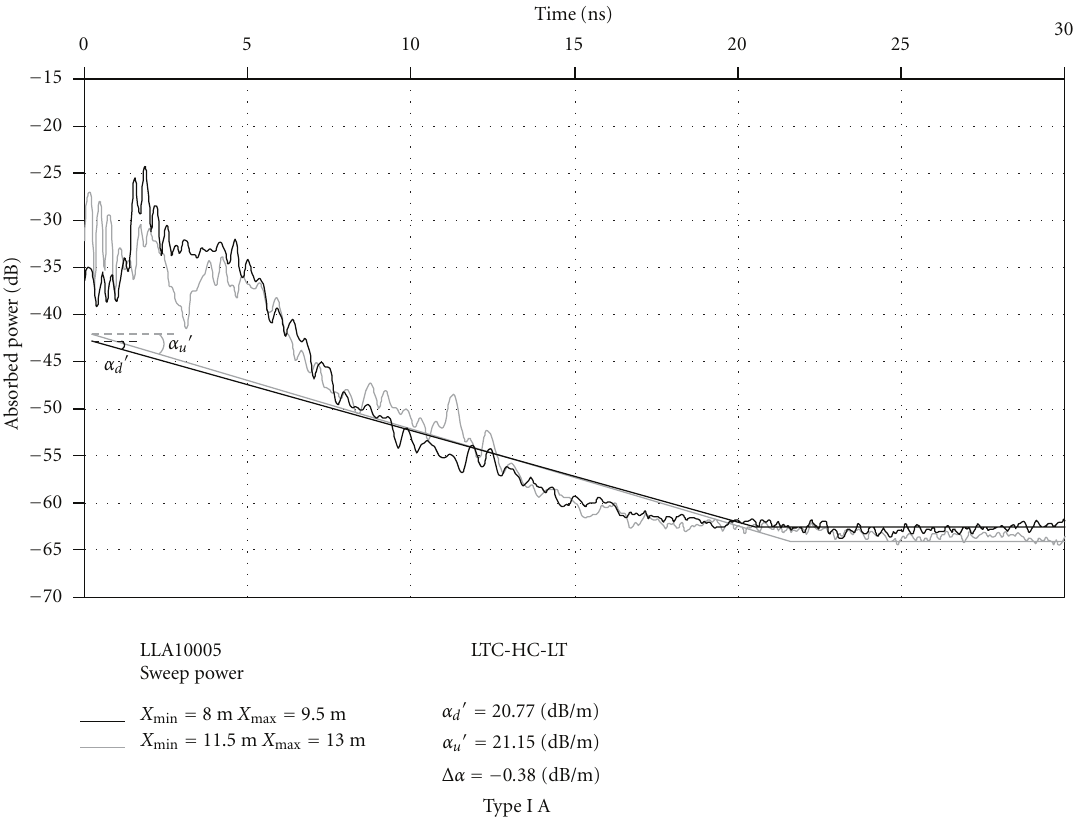
Figure 9: Power diagram (case Δ α ∼= 0) of the 1600 MHz section reported in Figure 5.